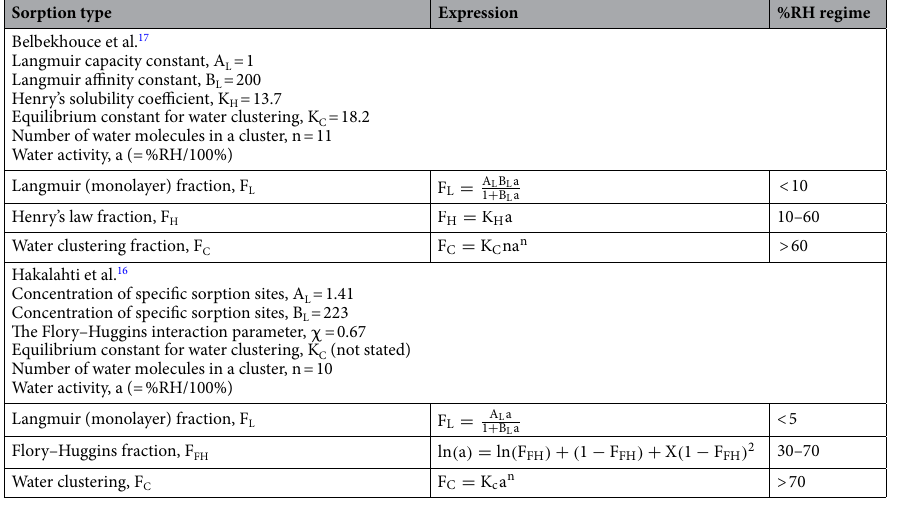
Table 1. Water sorption model—expressions as described by Belbekhouche et al. 17 for the MFC type of nanocellulose and Hakalahti et al., for TEMPO-oxidized CNF 16